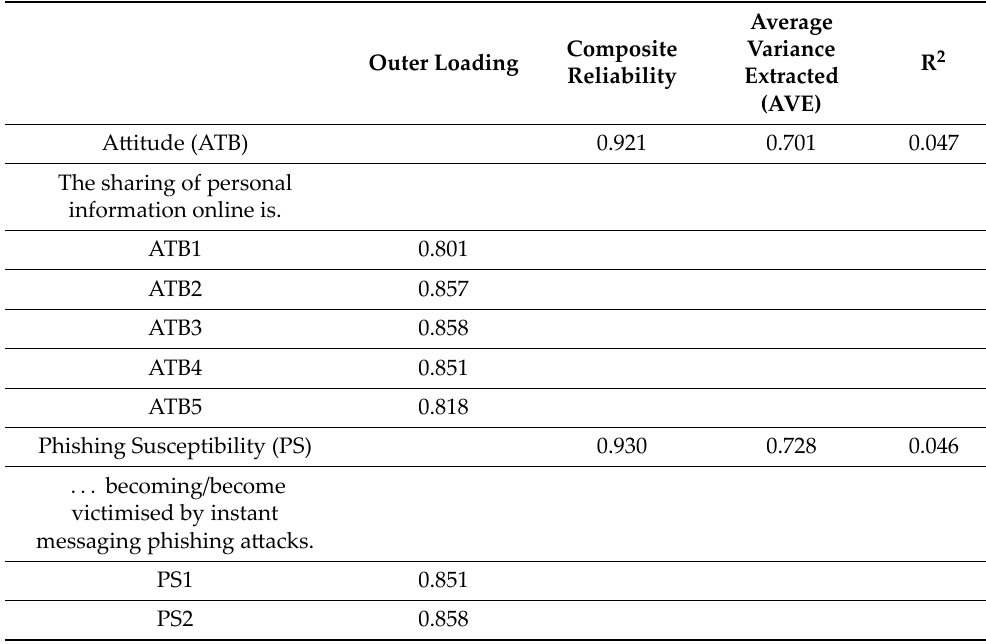
Table 3. Convergent